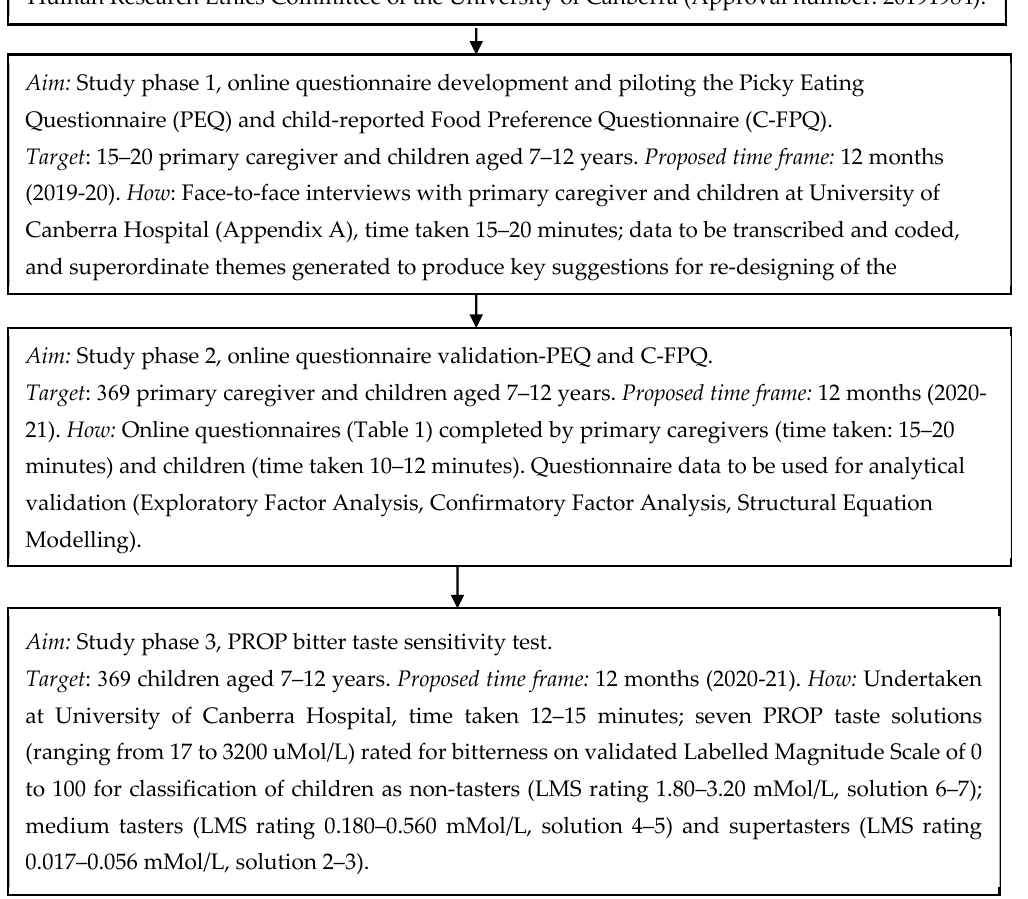
Figure 2. Flow chart of the picky eating–bitter taste sensitivity pilot study protocol.